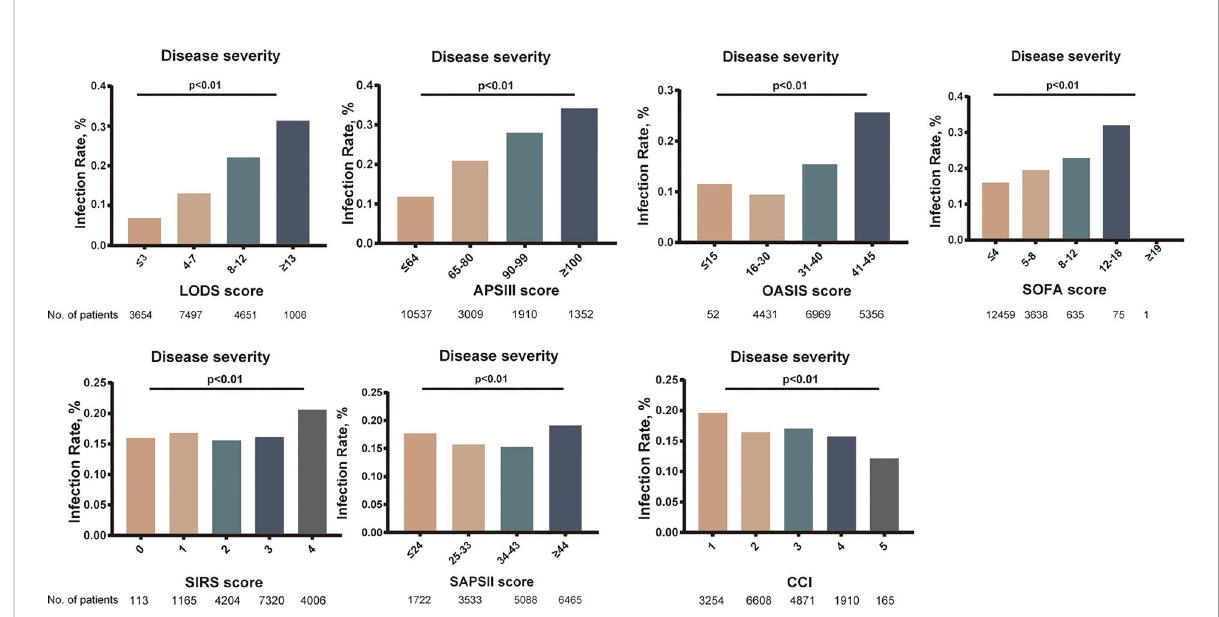
TABLE 3 Comparison of score models between ICU-acquired infection and no ICU-acquired infection with sepsis. Covariates